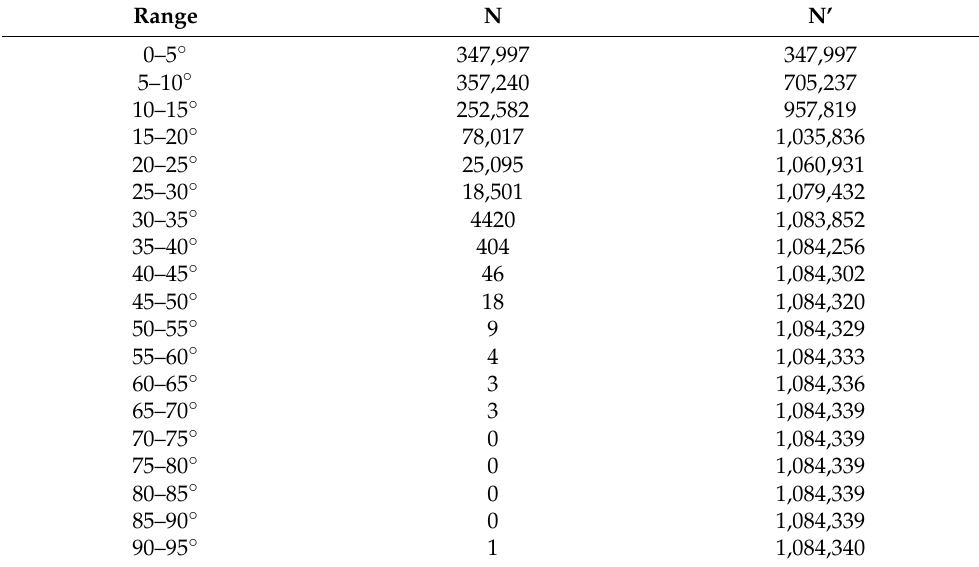
Table 7. Distribution of the orbital inclinations of all the MB asteroids. N is the number of objects with inclination i in each range, while N’ is the number of objects with i less than or equal to the second extreme of each range. Note that a non-negligible percentage of the entire population of the asteroidal MB, equal to 4%, has orbital inclinations greater than 20 ◦ ; note also the only MB asteroid (2010 EQ169) with an orbital inclination greater than 90 ◦ (see text). Data taken from the NASA/JPL Small-Body Database